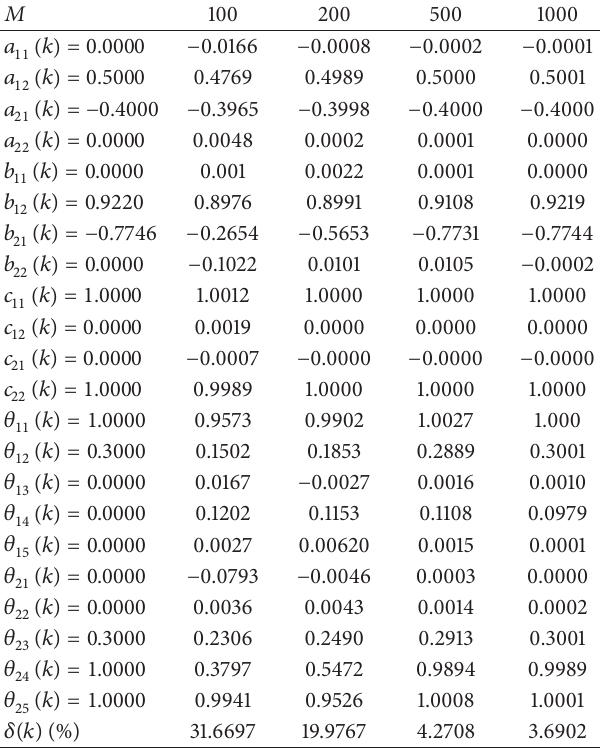
Table 1: The recursive parameter estimates and errors with 𝜎 𝑒2 = 0.01